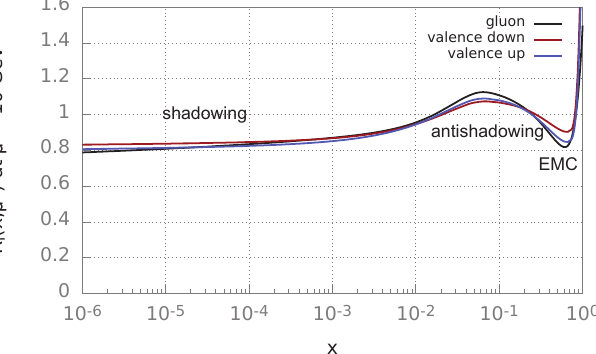
Figure 16. Modification of the nuclear PDFs EPPS16 [92] for gluons, up- and down-quarks as function of the momentum fraction x at 10 − 6 < x ≤ 1: Shadowing at x ≤ 0.02, antishadowing at 0.02 < x < 0.3. (From Dinh, MSc thesis HD 2019, unpublished. Reproduced with